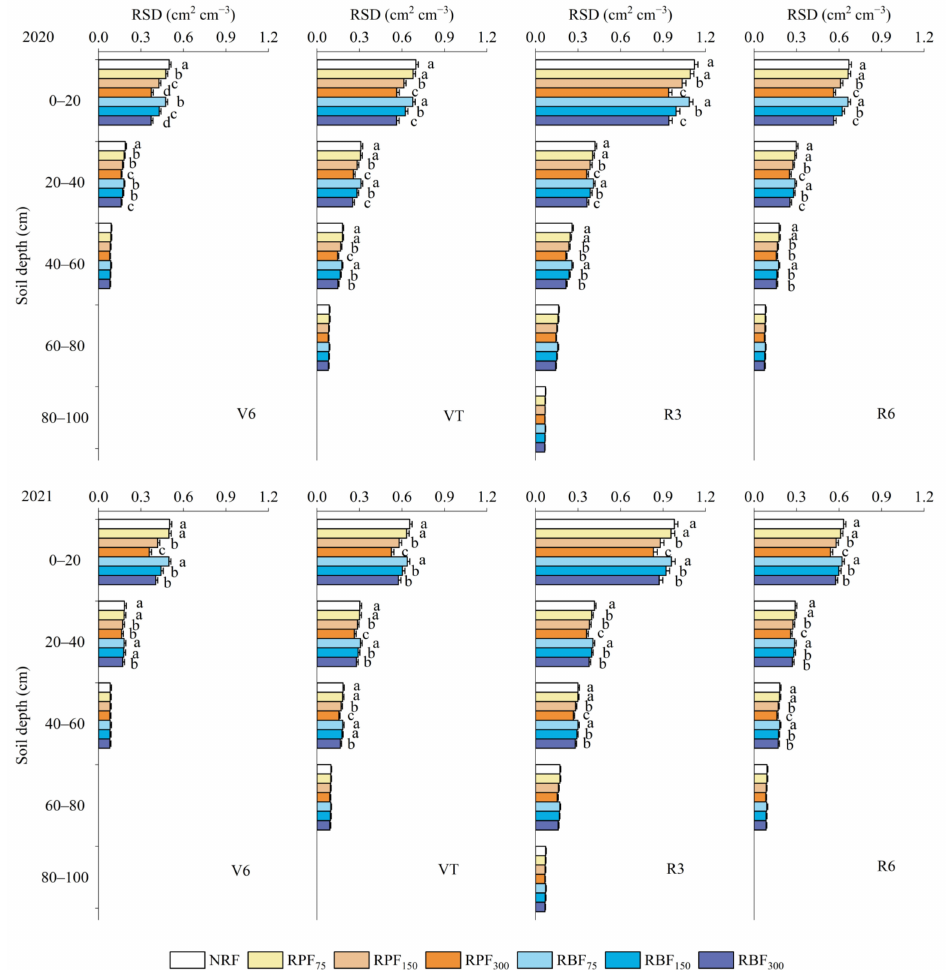
Figure 6. Root surface area density (RSD) in different soil layers in 2020 and 2021 spring maize growing seasons. Horizontal bars represent the standard error of the mean. Different lowercase letters indicate significant ( p < 0.05) differences based on the LSD